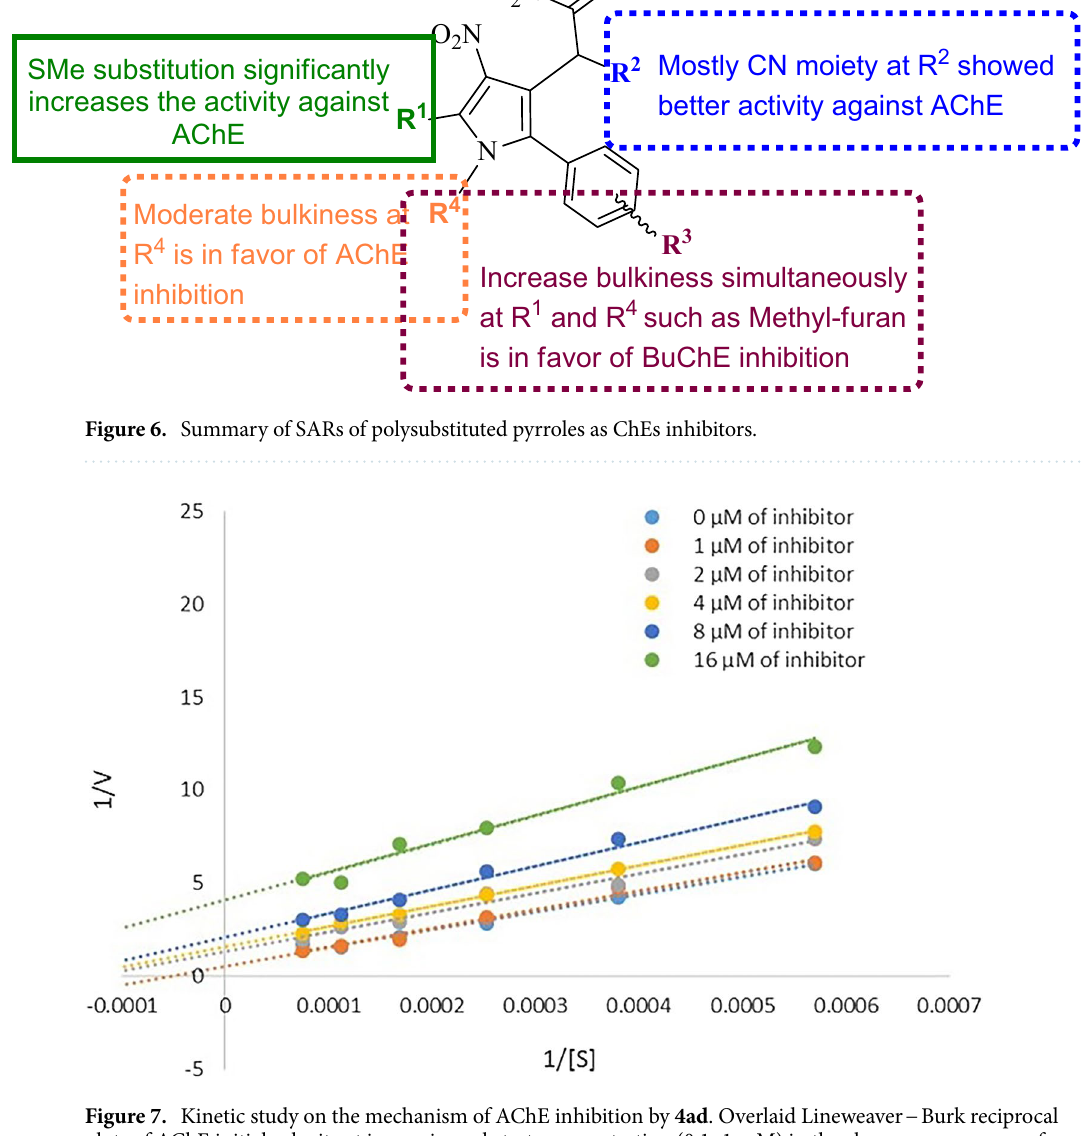
Figure 7. Kinetic study on the mechanism of AChE inhibition by 4ad . Overlaid Lineweaver − Burk reciprocal plots of AChE initial velocity at increasing substrate concentration (0.1–1 mM) in the absence or presence of 4ad are